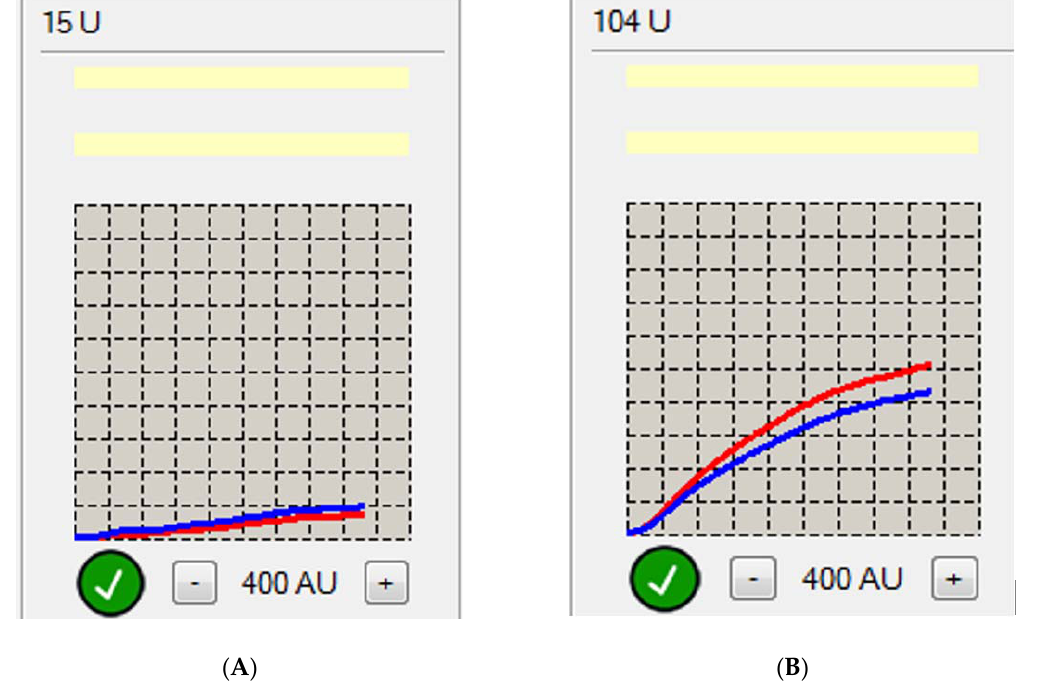
Figure1. Curvesofplateletreactivityassessedbyimpedanceaggregometry: ( A )Aspirin(ASA)-sensitive Figure 1. Curves of platelet reactivity assessed by impedance aggregometry: ( A ) Aspirin (ASA) ‐ subject with 15 area under the curve (AUC) ( B ) ASA-resistant subject with 104 AUC. First measurement- sensitive subject with 15 area under the curve (AUC) ( B ) ASA ‐ resistant subject with 104 AUC. First blue line, second measurement- red measurement ‐ blue line, second measurement ‐ red line.